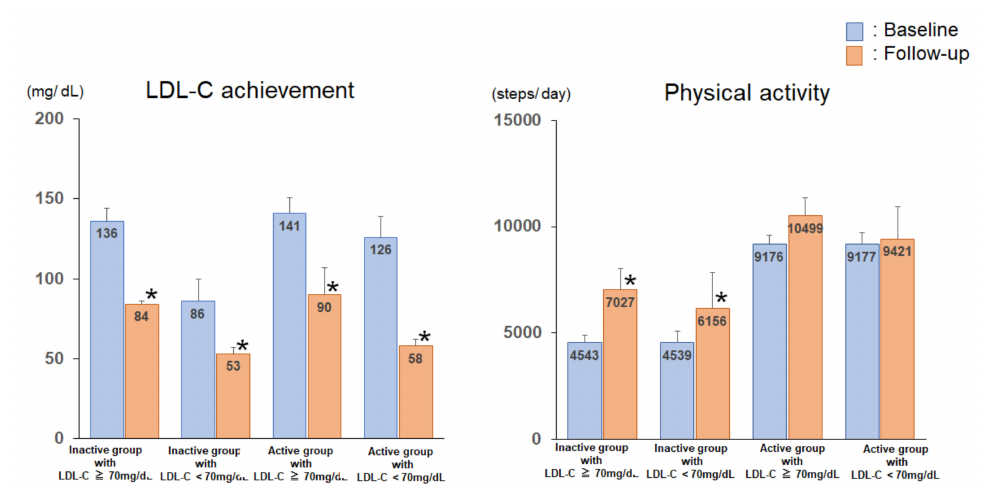
Figure 3. Comparison of the LDL-C achievement and physical activity among the four groups at baseline and at the follow-up. * p < 0.05 compared with the value at baseline.